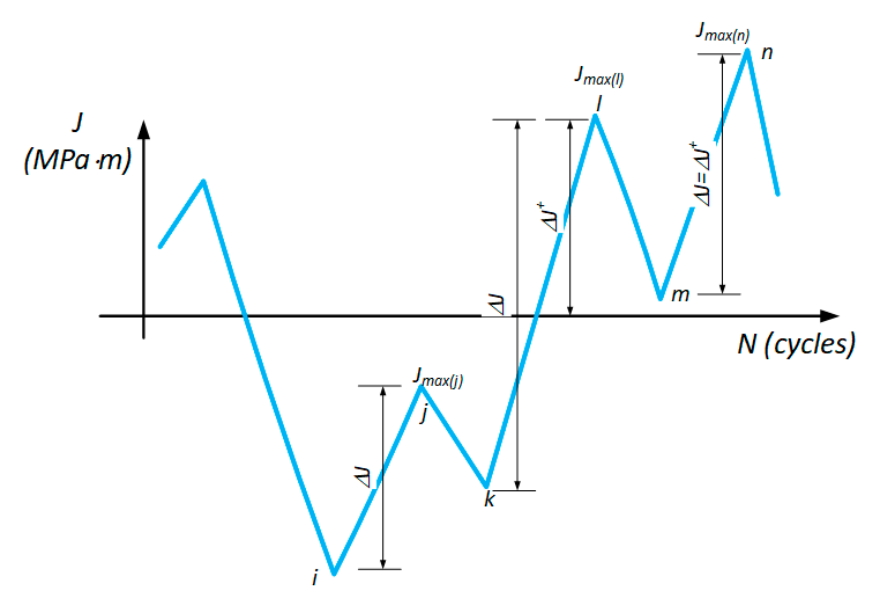
Figure 3. Schematic representation of the ∆ S* components during cyclic loading.